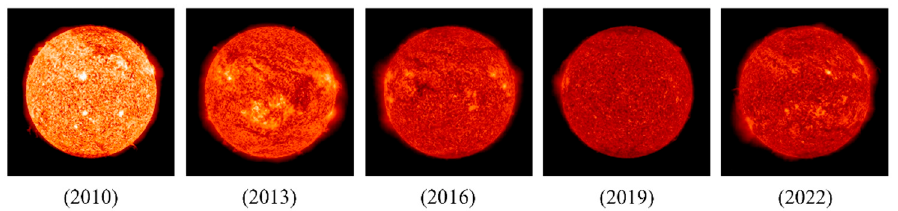
Figure 3. Sun photographed at 304 Å by SDO. Each image was taken on June 1 of the corresponding year.